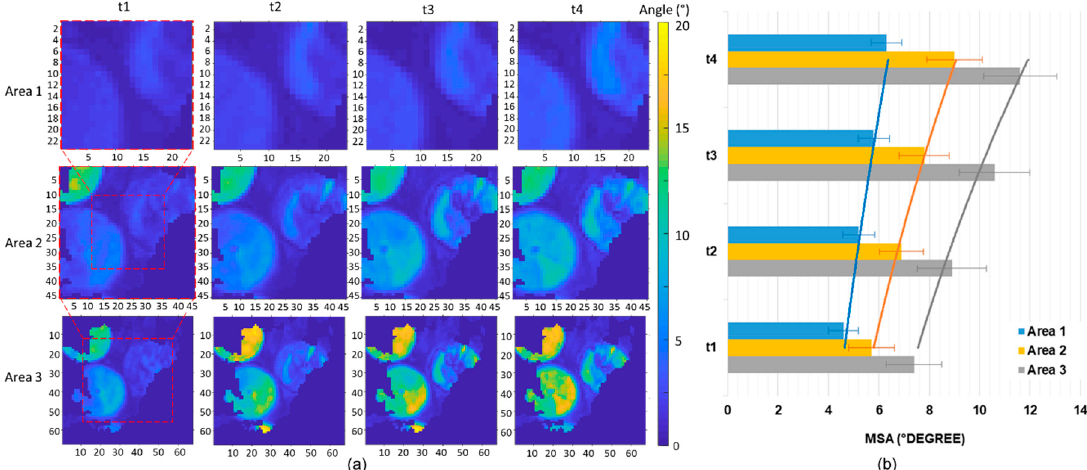
Figure 12. Evaluation of the spectral accuracy of the gap-filling spatiotemporal model, showing ( a ) spectral angle difference per retrieved time per each sampled area, and ( b ) MSA metric per retrieved time per each sampled area.